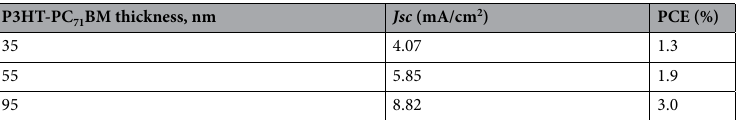
Table 1. Dependence of the short-circuit current density ( Jsc ) and power conversion efficiency ( PCE ) on the P3HT-PC 71 BM